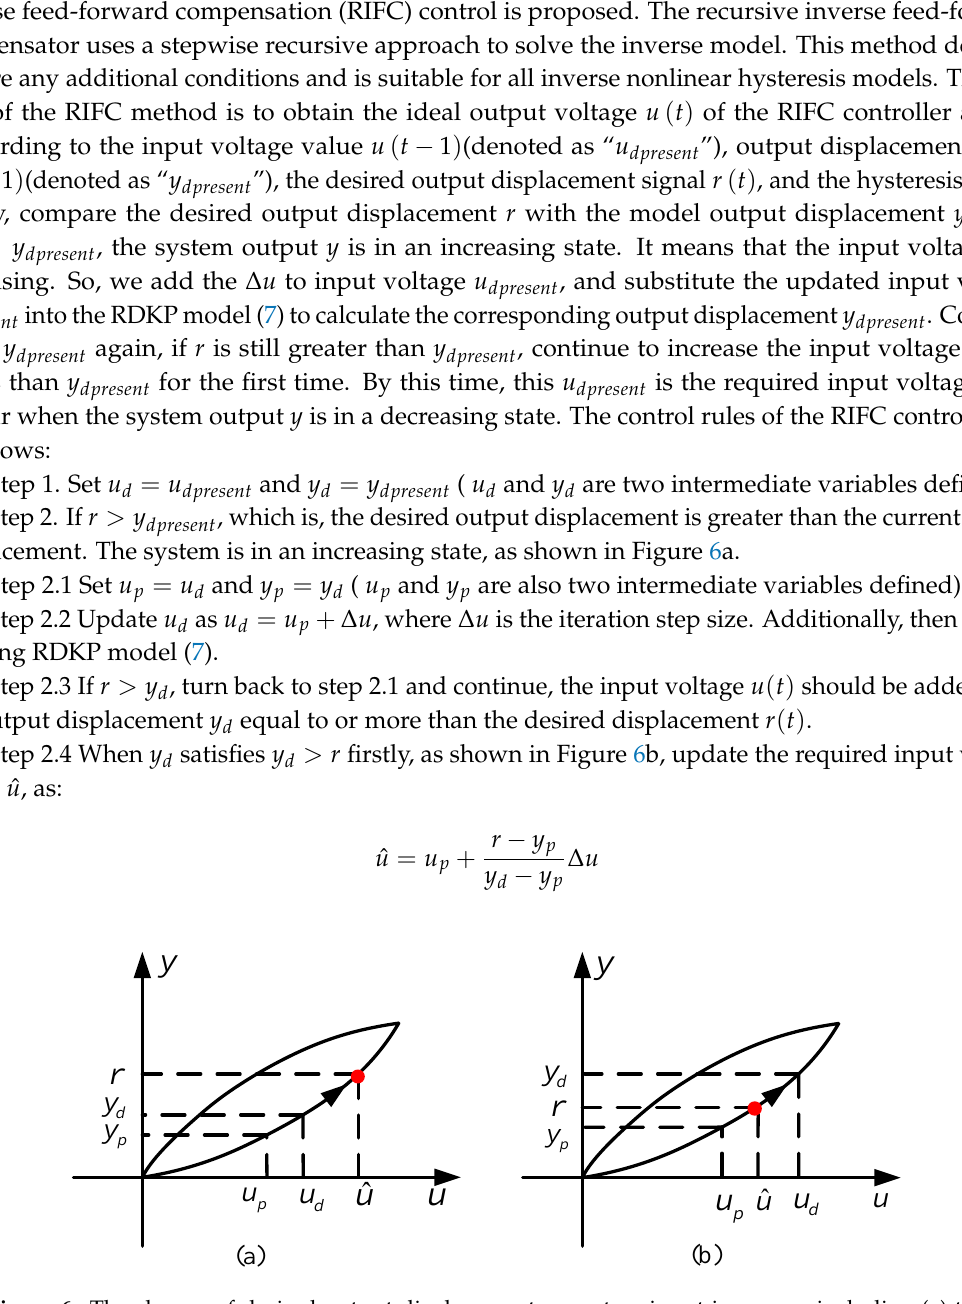
Figure 6. The change of desired output displacement as system input increases, including ( a ) the current output displacement is less than the desired output displacement and ( b ) the current output displacement exceeds the desired output displacement for the first